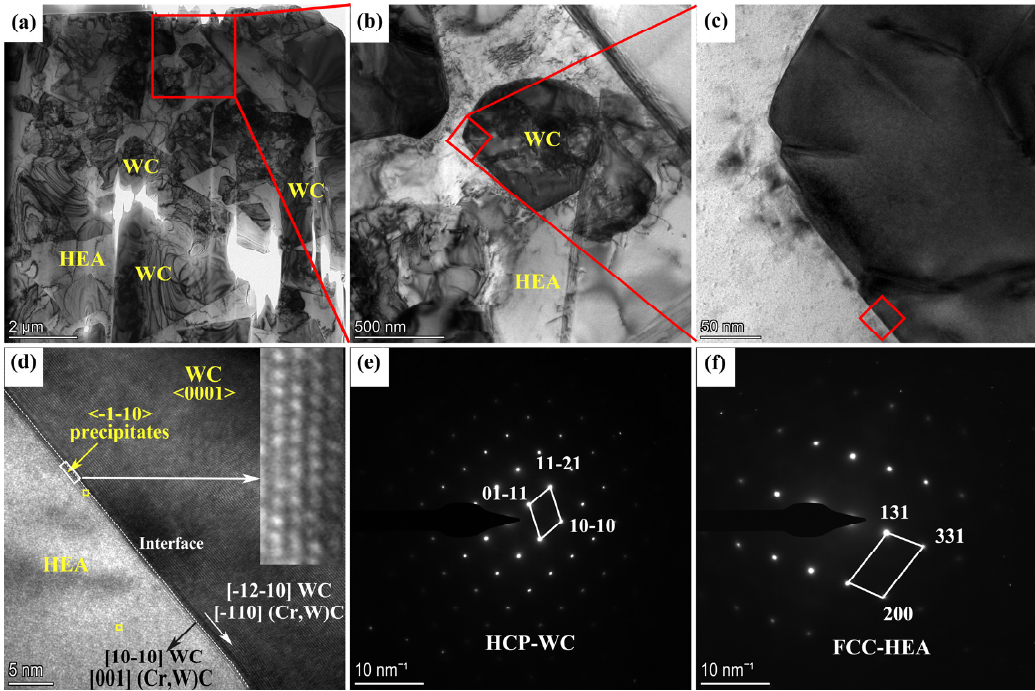
Figure 7. TEM analysis of Alloy 5: ( a ) TEM bright field image, ( b ) enlarged view of the red rectangle in ( a ), ( c ) steps at the WC/HEA interface, ( d ) HREM image of the WC/HEA interface viewed along <0001> WC //< ‐ 1 ‐ 10> (Cr,W)C , ( e ) FFT pattern of WC and ( f ) FFT pattern of HEA. Table 2. EDS composition (at.%) in the binder and at the interface in Alloy 5. 254